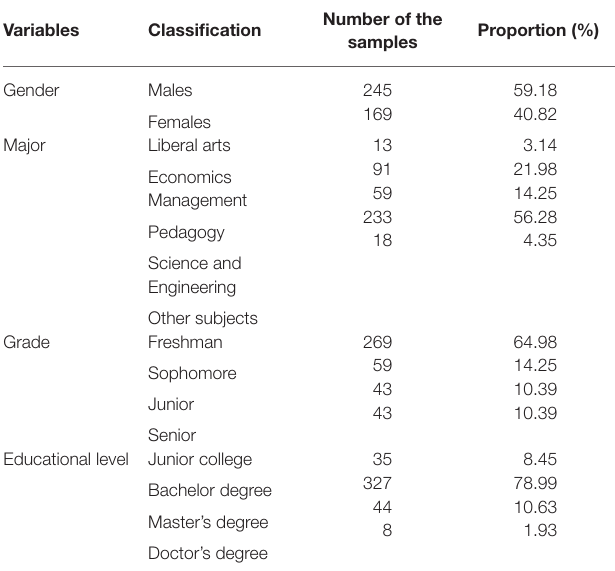
TABLE 1 | Distribution of samples ( N =